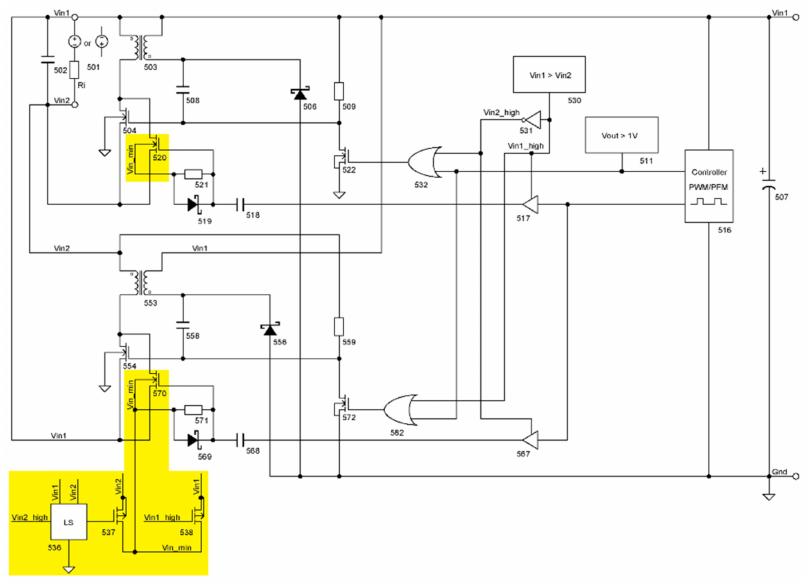
Figure 5. DC / DC converter with improved bulk connection [15].